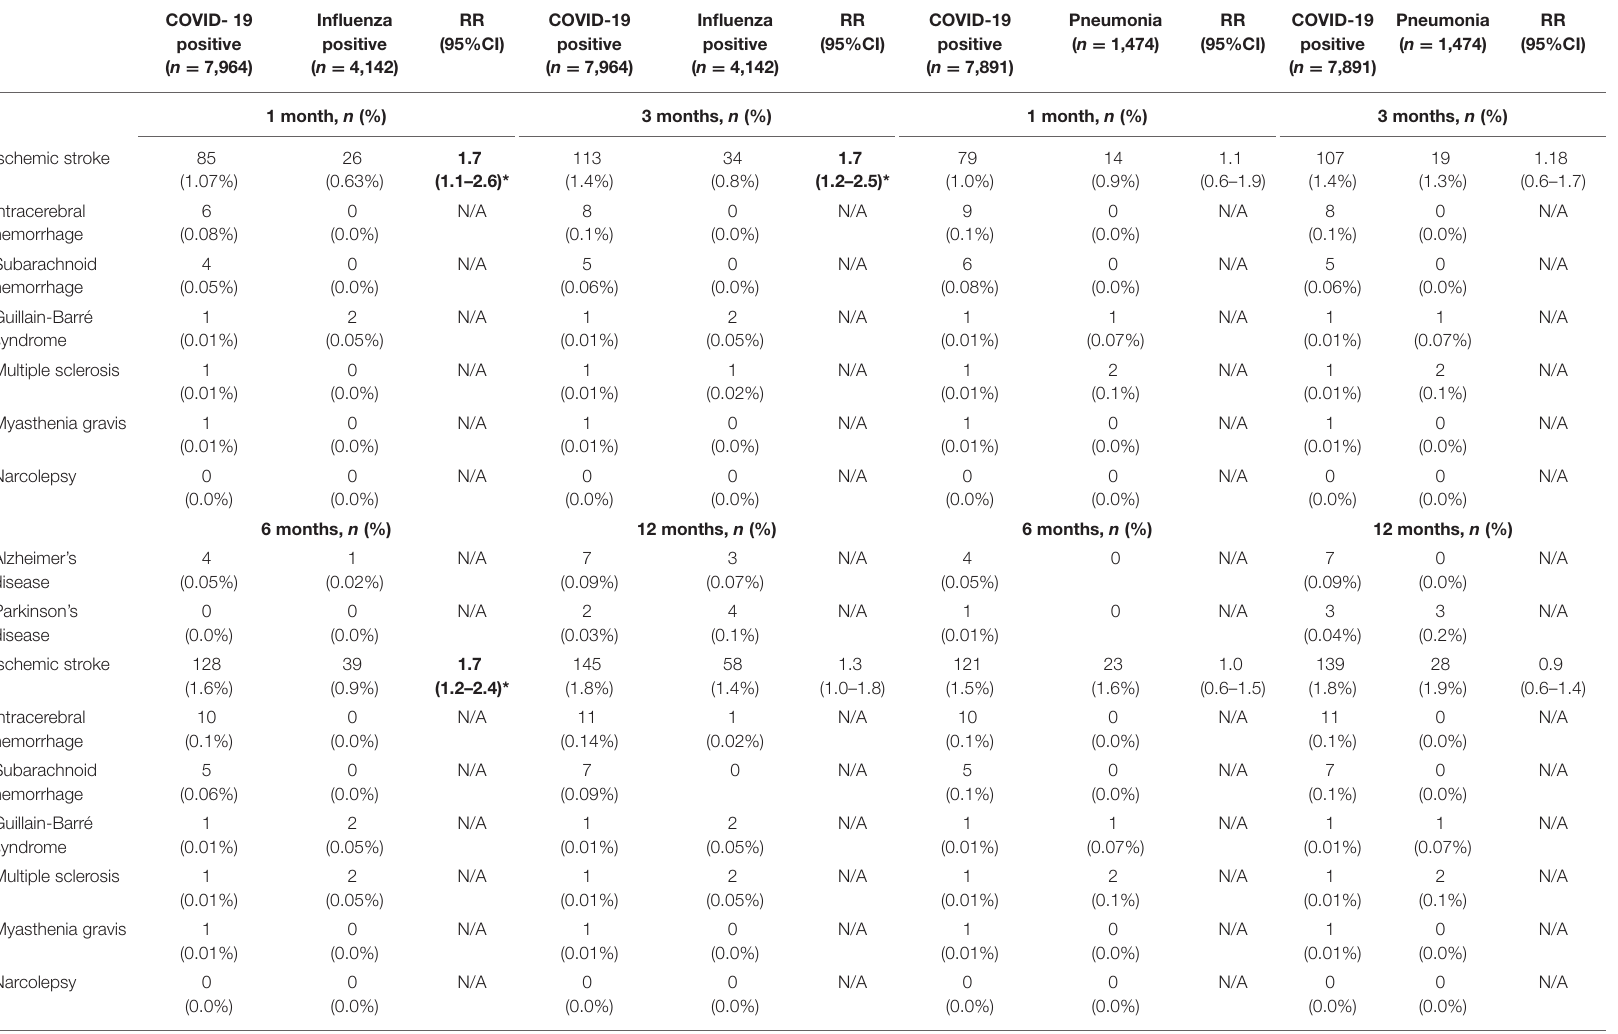
TABLE 3 | Relative risk of neurodegenerative, cerebrovascular and neuroimmune disorders in inpatients with COVID-19 compared to influenza inpatients and community-acquired bacterial pneumonia